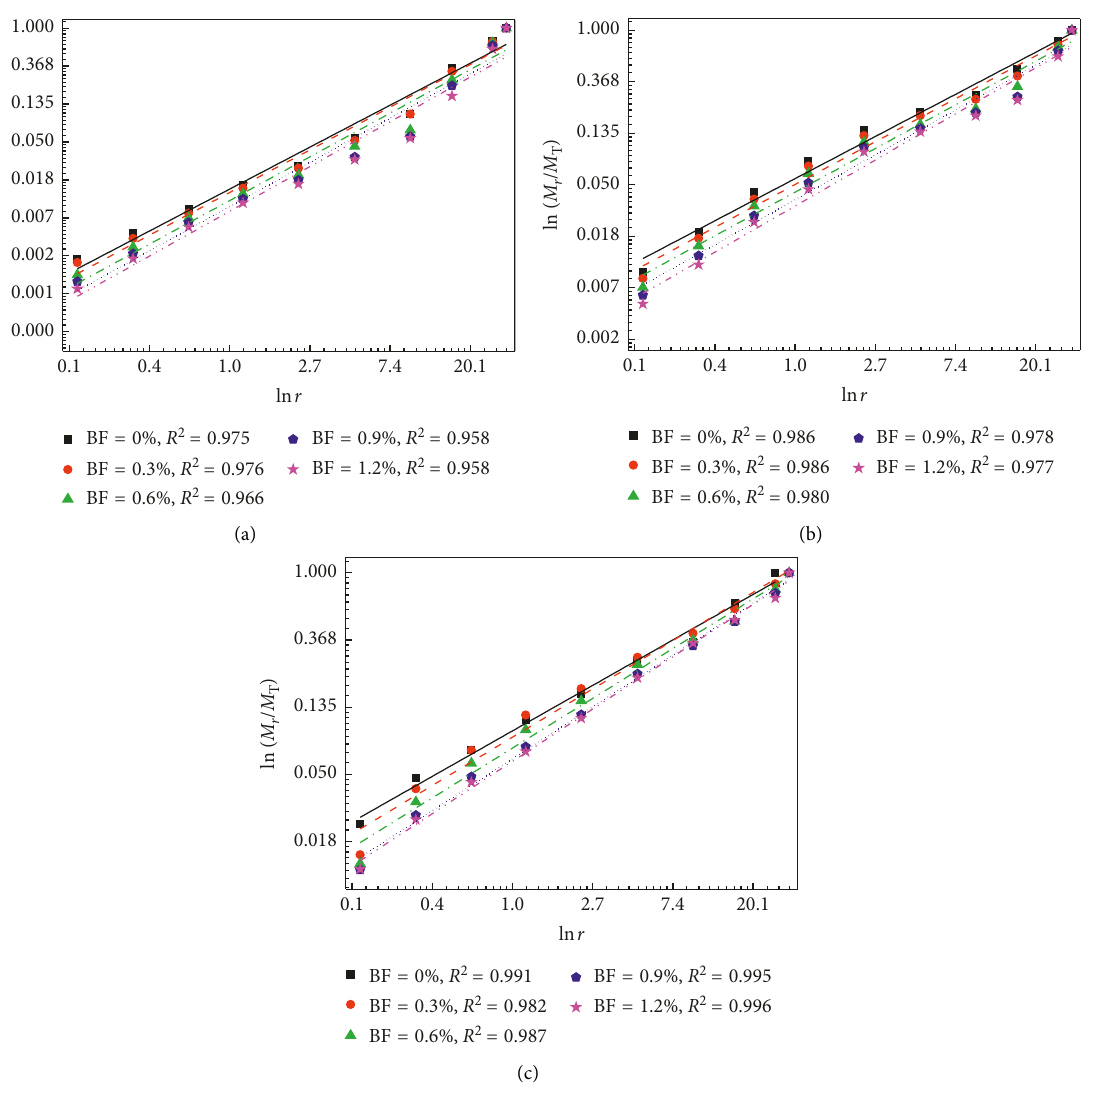
Figure 18: Diagrams of ln ( M impact loading